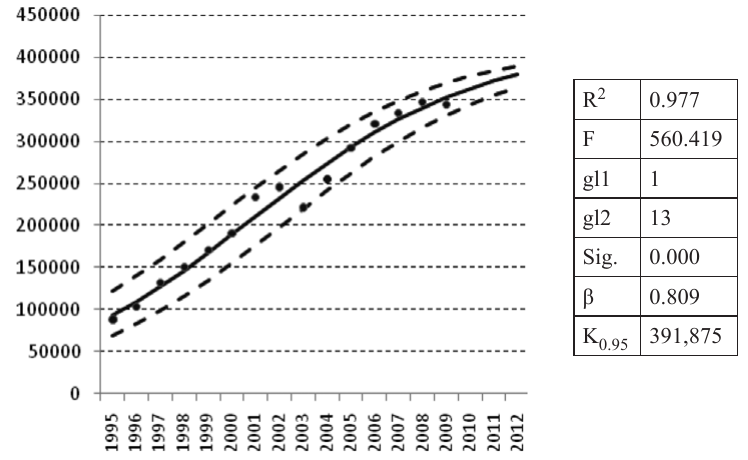
Fig. 8. Forecast of the ISO 9000 certificates in the EU-15 Source: Own preparation on the basis of ISO full reports of global statistics for ISO 9000 (ISO